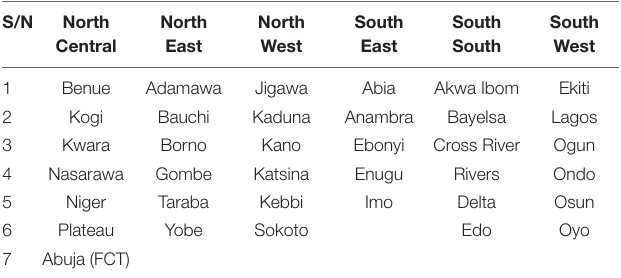
TABLE 1 | States in the six geopolitical zones of